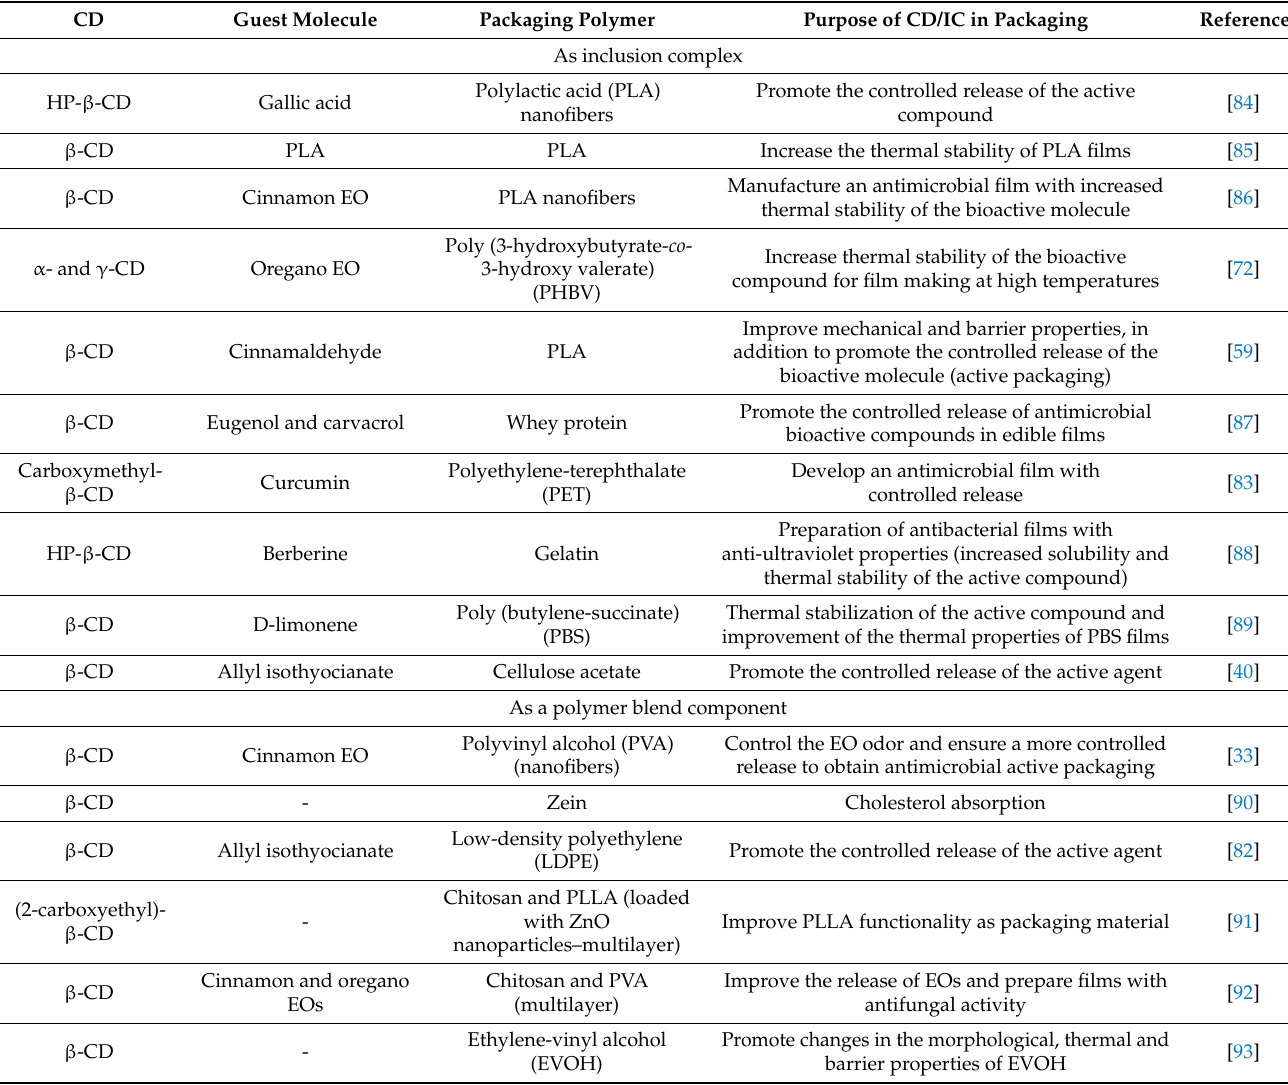
Table 3. Cyclodextrins (CDs) in food packaging. Packaging Polymer Purpose of CD/IC in